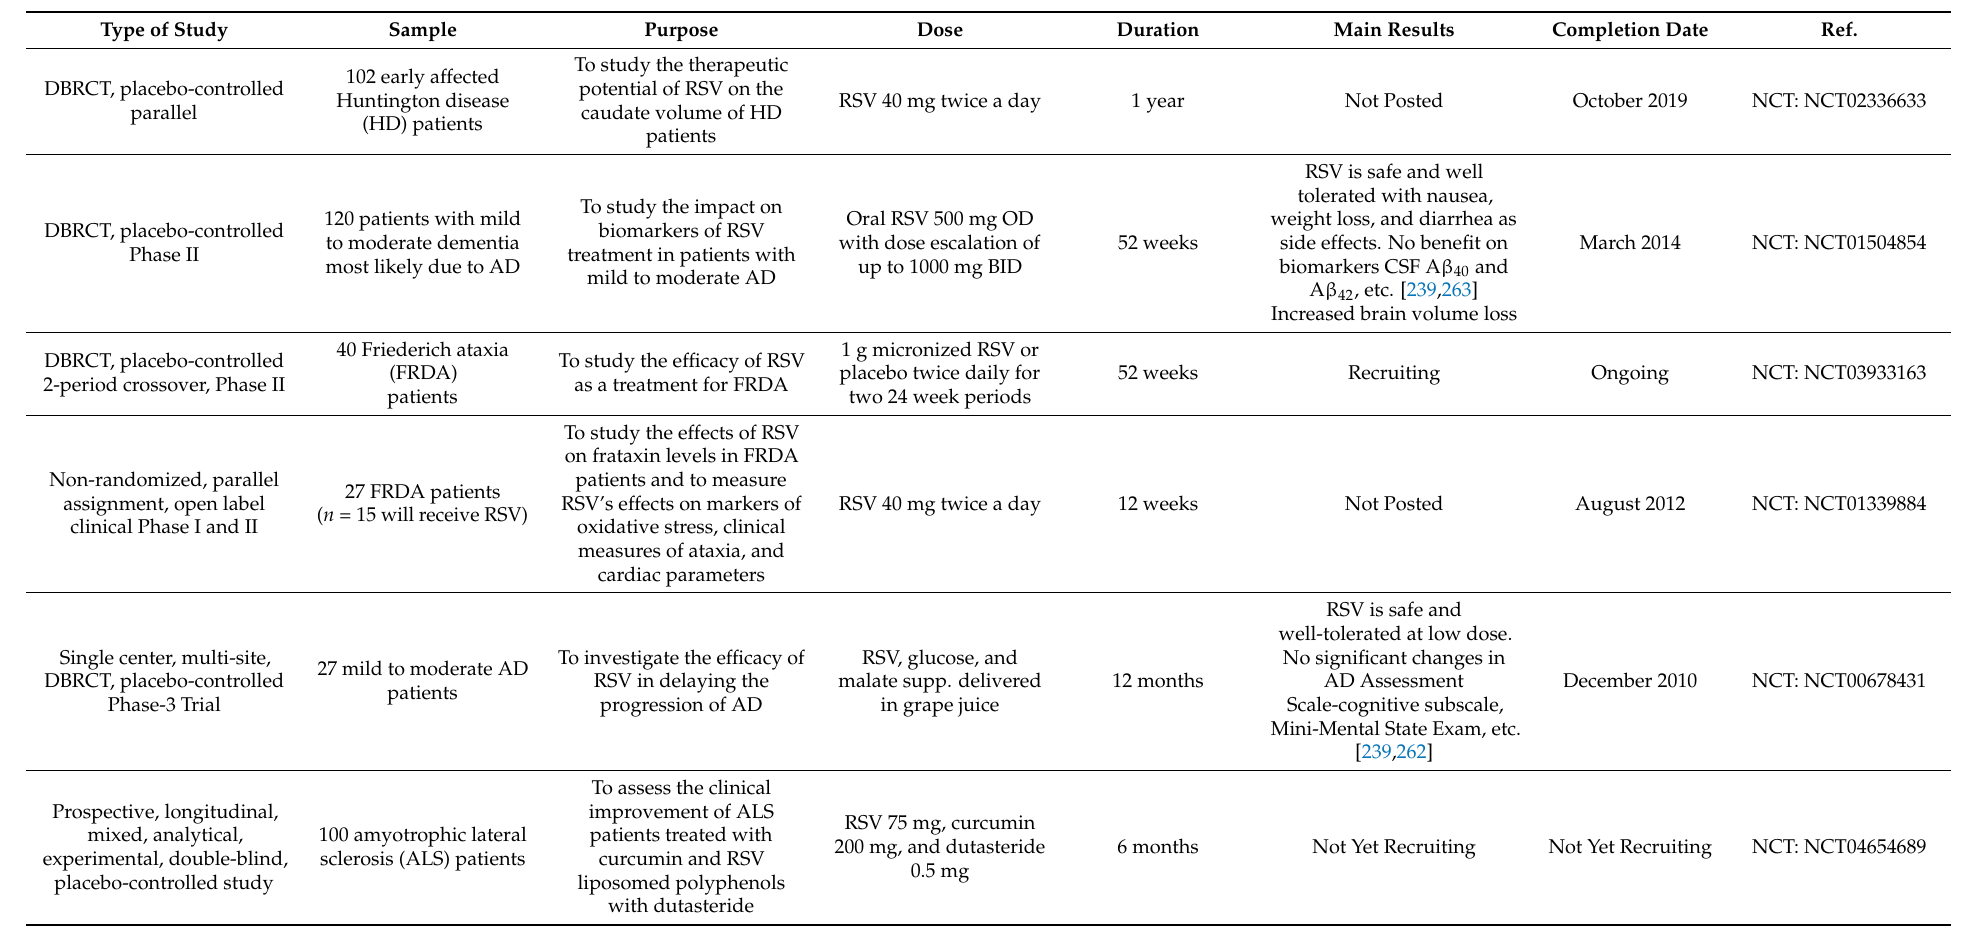
Table 3. Clinical trials of resveratrol on non-PD neurodegenerative